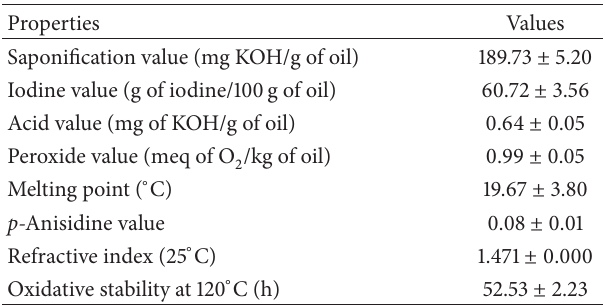
Table 4: Chemical and physical properties of Lannea kerstingii seed oil.